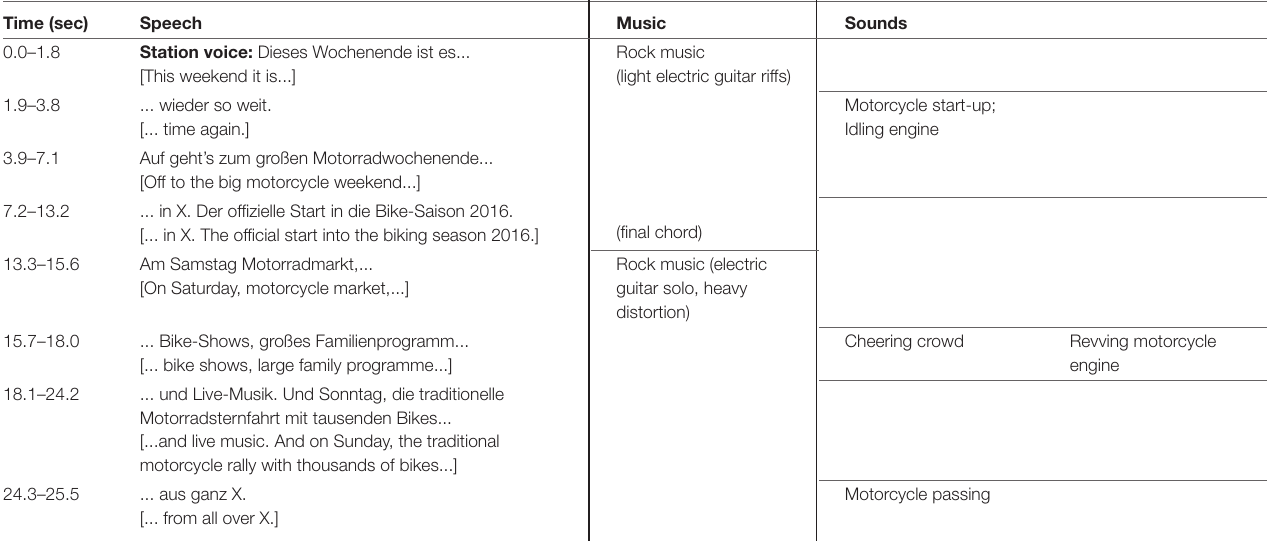
TABLE 2 | Promotion